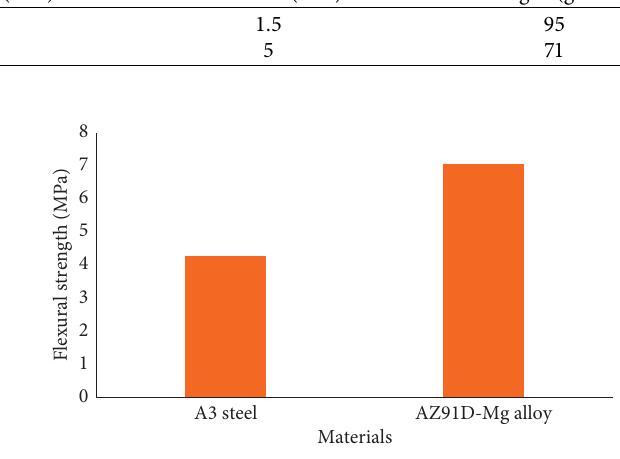
Figure 12: Flexural strength for both